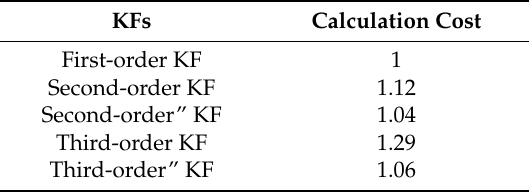
Table 3. Calculation costs of the higher-order Kalman filters (KFs) with respect to the first-order